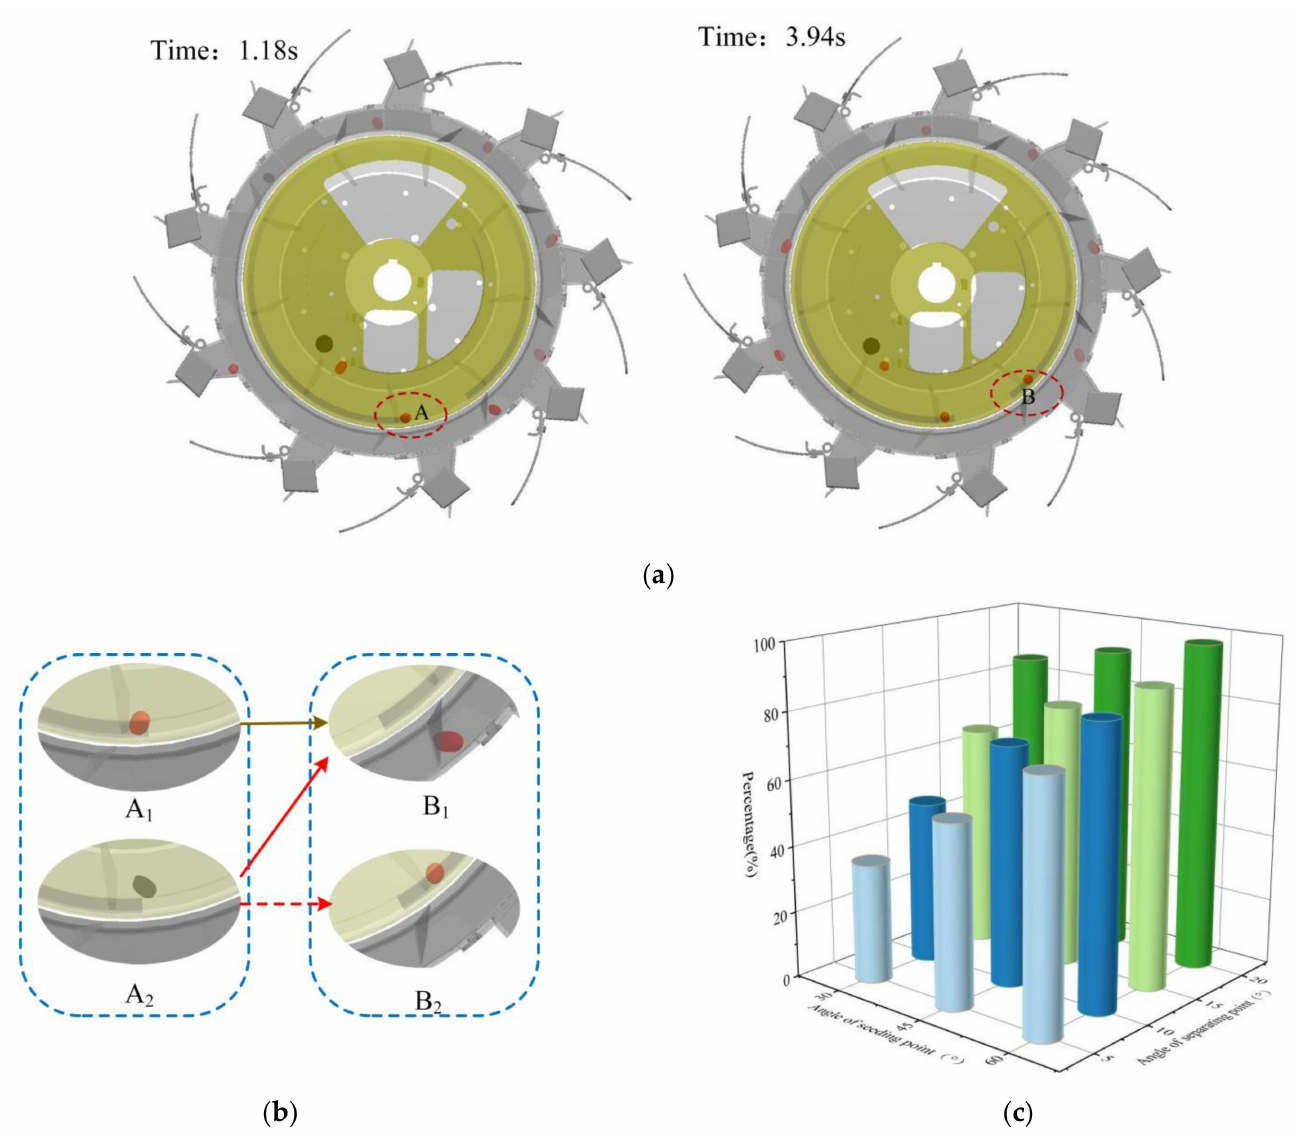
Figure 9. ( a ) Seed distributions at different moments: ( b ) effects of different separation methods; ( c ) effects of different IACB and IADC on contact